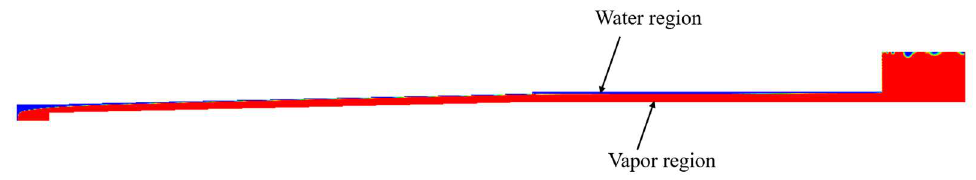
Figure 4. The distribution of the water film.